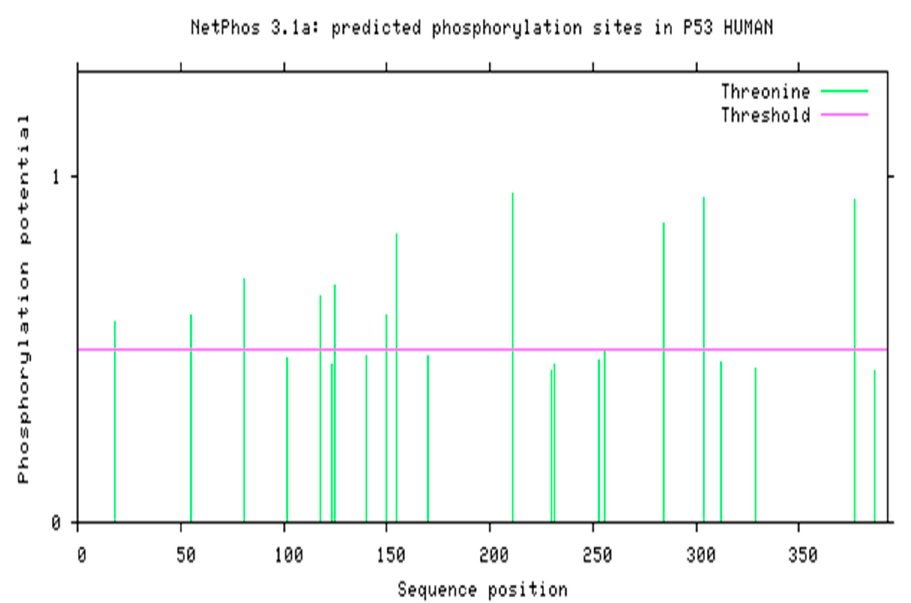
Figure 10. TPD1-like protein’s predicted phosphorylation locations.